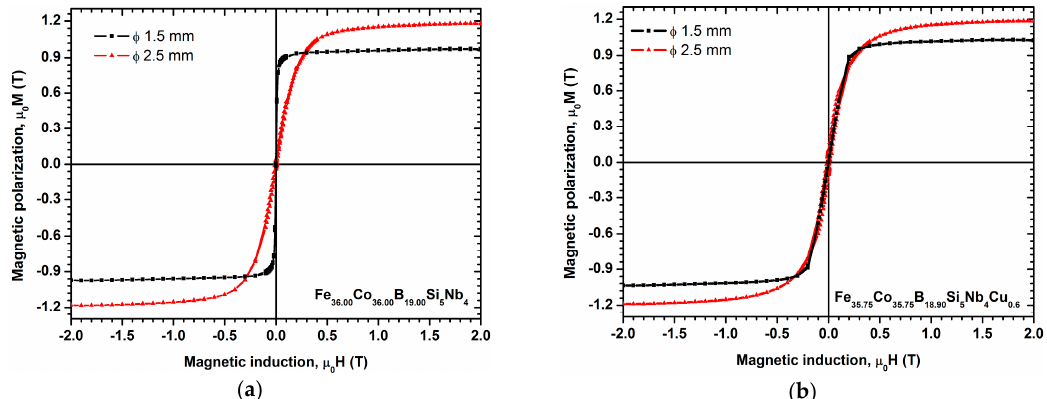
Figure 14. Room temperature magnetic hysteresis loops measured at a maximum magnetic induction of μ 0 H = 2 T for samples of ( a ) Fe 36.00 Co 36.00 B 19.00 Si 5 Nb 4 and ( b ) Fe 35.75 Co 35.75 B 18.90 Si 5 Nb 4 Cu 0.6 alloys in rod form with diameters of 1.5 and 2.5 mm. Table 1. The results of magnetic properties ( μ i , Δμ / μ , H c , J s ) of the test specimens from the